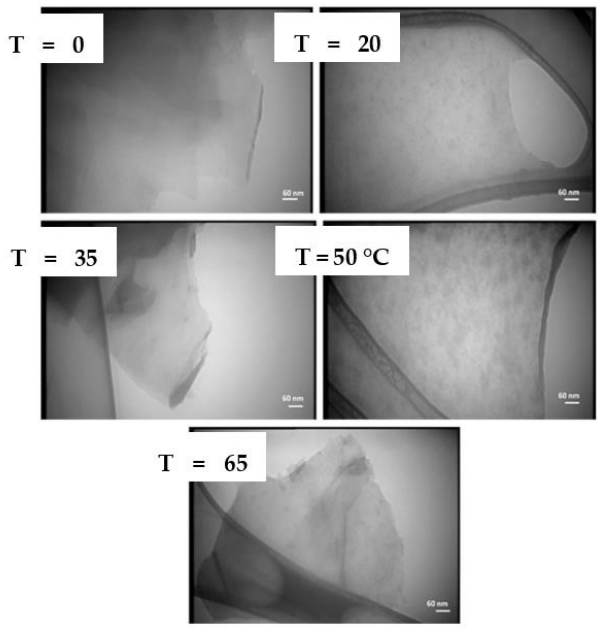
Figure 19. The effect of liquid temperature on the formation of GNS [57].